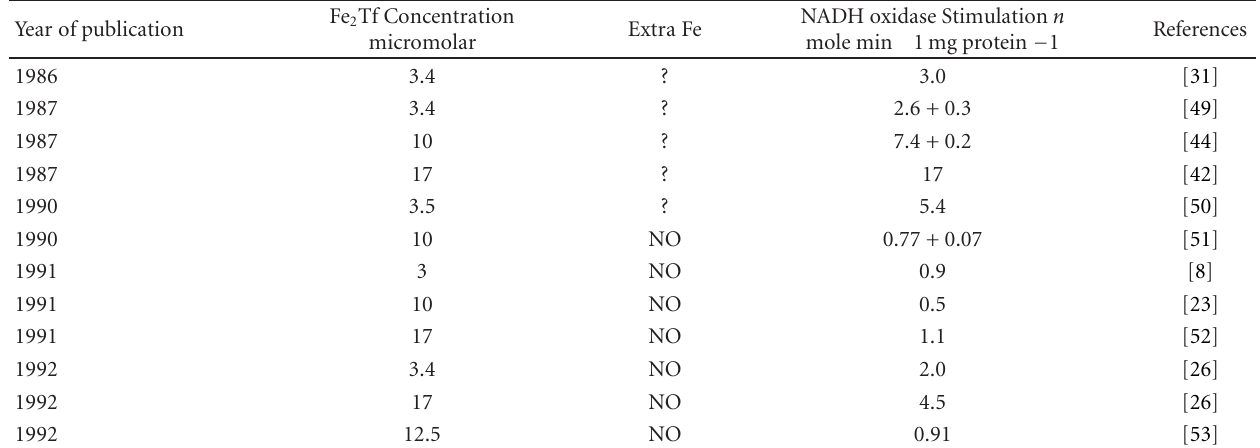
Table 1: Stimulation of NADH oxidase of rat liver plasma membrane by diferric transferrin (Fe 2 Tf) with control of adventious iron in the Fe 2 Tf.